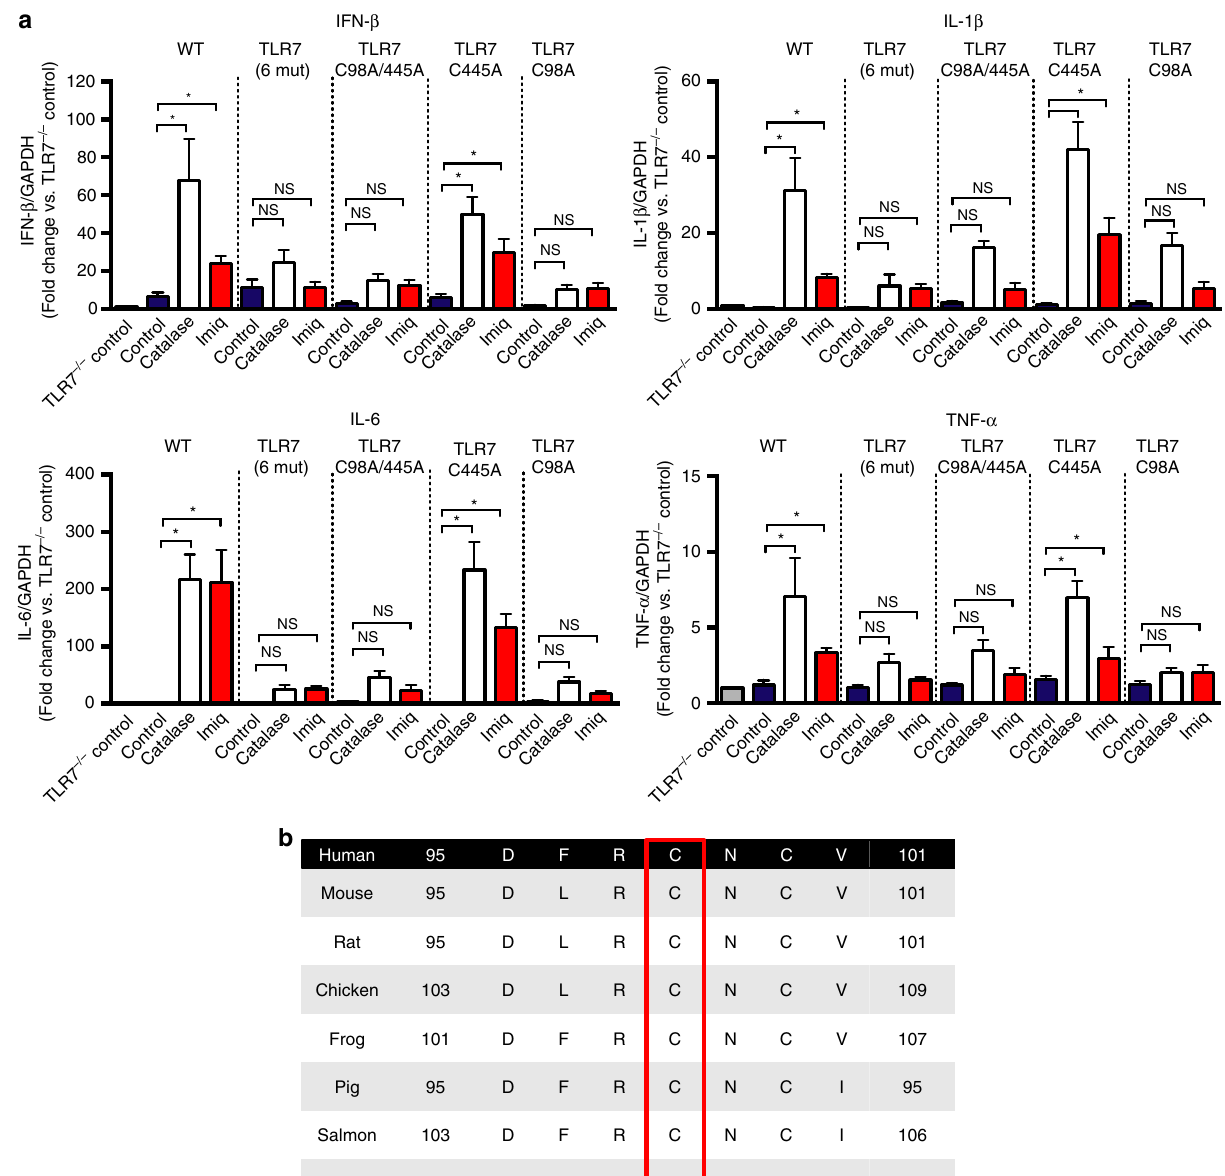
Fig. 7 C98 on TLR7 regulates activity of the receptor and is a target for endosomal H 2 O 2 . a TLR7 − / − BMDMs were transfected with empty vector, WT TLR7 or with either TLR7 with cysteines 98, 260, 263, 270, 273, and 445 mutated to alanine (TLR7 6 mut), TLR7 with cysteines 98 and 445 mutated to alanine (TLR7C98A/445 A) or with TLR7 with cysteines 445 (TLR7C445A) or 98 (TLR7C98A) mutated to alanine. After 48 h, cells were left untreated or treated for 1 h with either catalase (1000 U/ml) or imiquimod (Imiq, 10 μ g/ml) and cytokine expression assessed 24 h later ( n = 6). Responses are relative to GAPDH and then expressed as a fold-change above TLR7 − / − controls. Data are represented as mean ± S.E.M. One-way ANOVA followed by Dunnett ’ s post hoc test for multiple comparisons. Statistical signi fi cance was accepted when P < 0.05. * P < 0.05. (NS) Denotes not signi fi cant. b Multiple sequence alignment with CLUSTAL OMEGA showing across species conservation of Cys 98 on